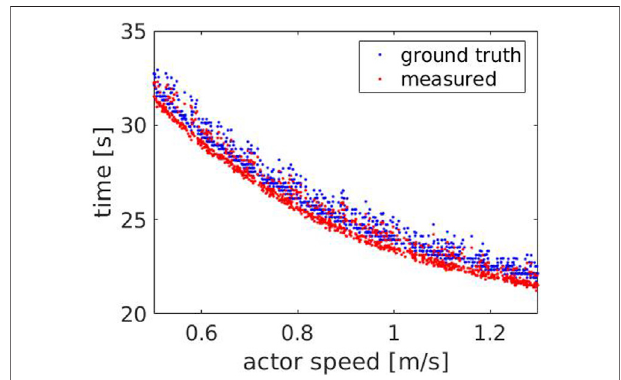
FIGURE 5 | The error in time for all the experiments (1, 2 and 3).